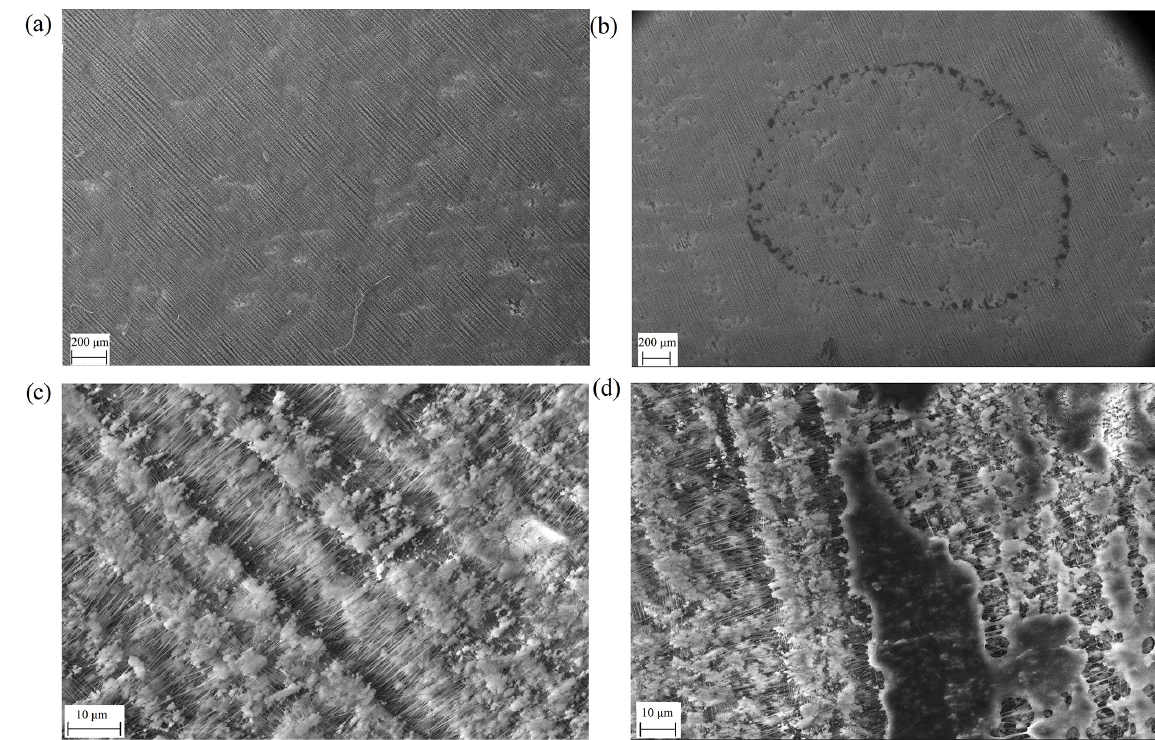
Figure 5. SEM pictures. (a) A total of 10µL of pure ACN deposited on the filter. (b) A total of 3µL of PEG-8 with a concentration of 0.01gL − 1 (30ng) in ACN deposited on the filter. (c) Magnification shows magnification (a) and panel (d) shows magnification of the PEG-8 residue.